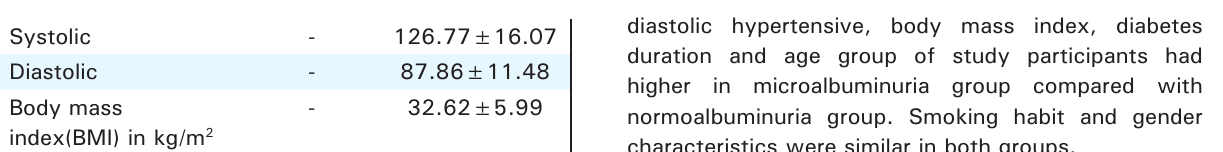
Table 2 demonstrates the comparisons of personal profile of the study participants with or without microalbuminuria. Systolic hypertensive,